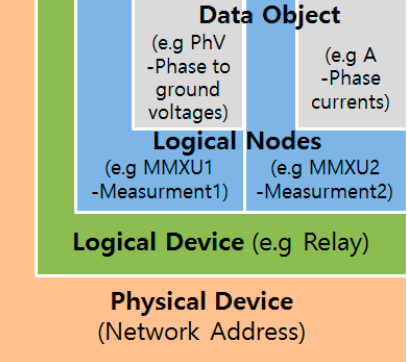
Figure 4. IEC 61850 information model (Source: IEC 61850-7-2).